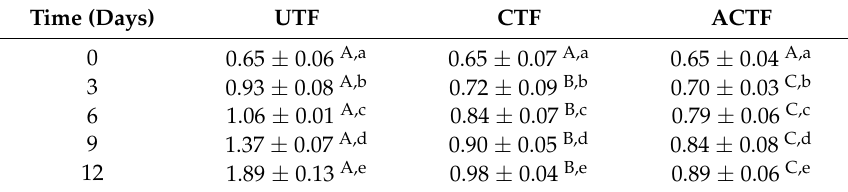
Table 2. Thiobarbituric acid reactive substances (TBARS) (mg malonadehyde kg − 1 sample) values in samples of uncoated and coated trout fillets during refrigerated storage at 4 ◦ C for 12 days *. UTF = uncoated; CTF = carrageenan coated; ACTF = carrageenan coated with ELO. Time (Days) UTF